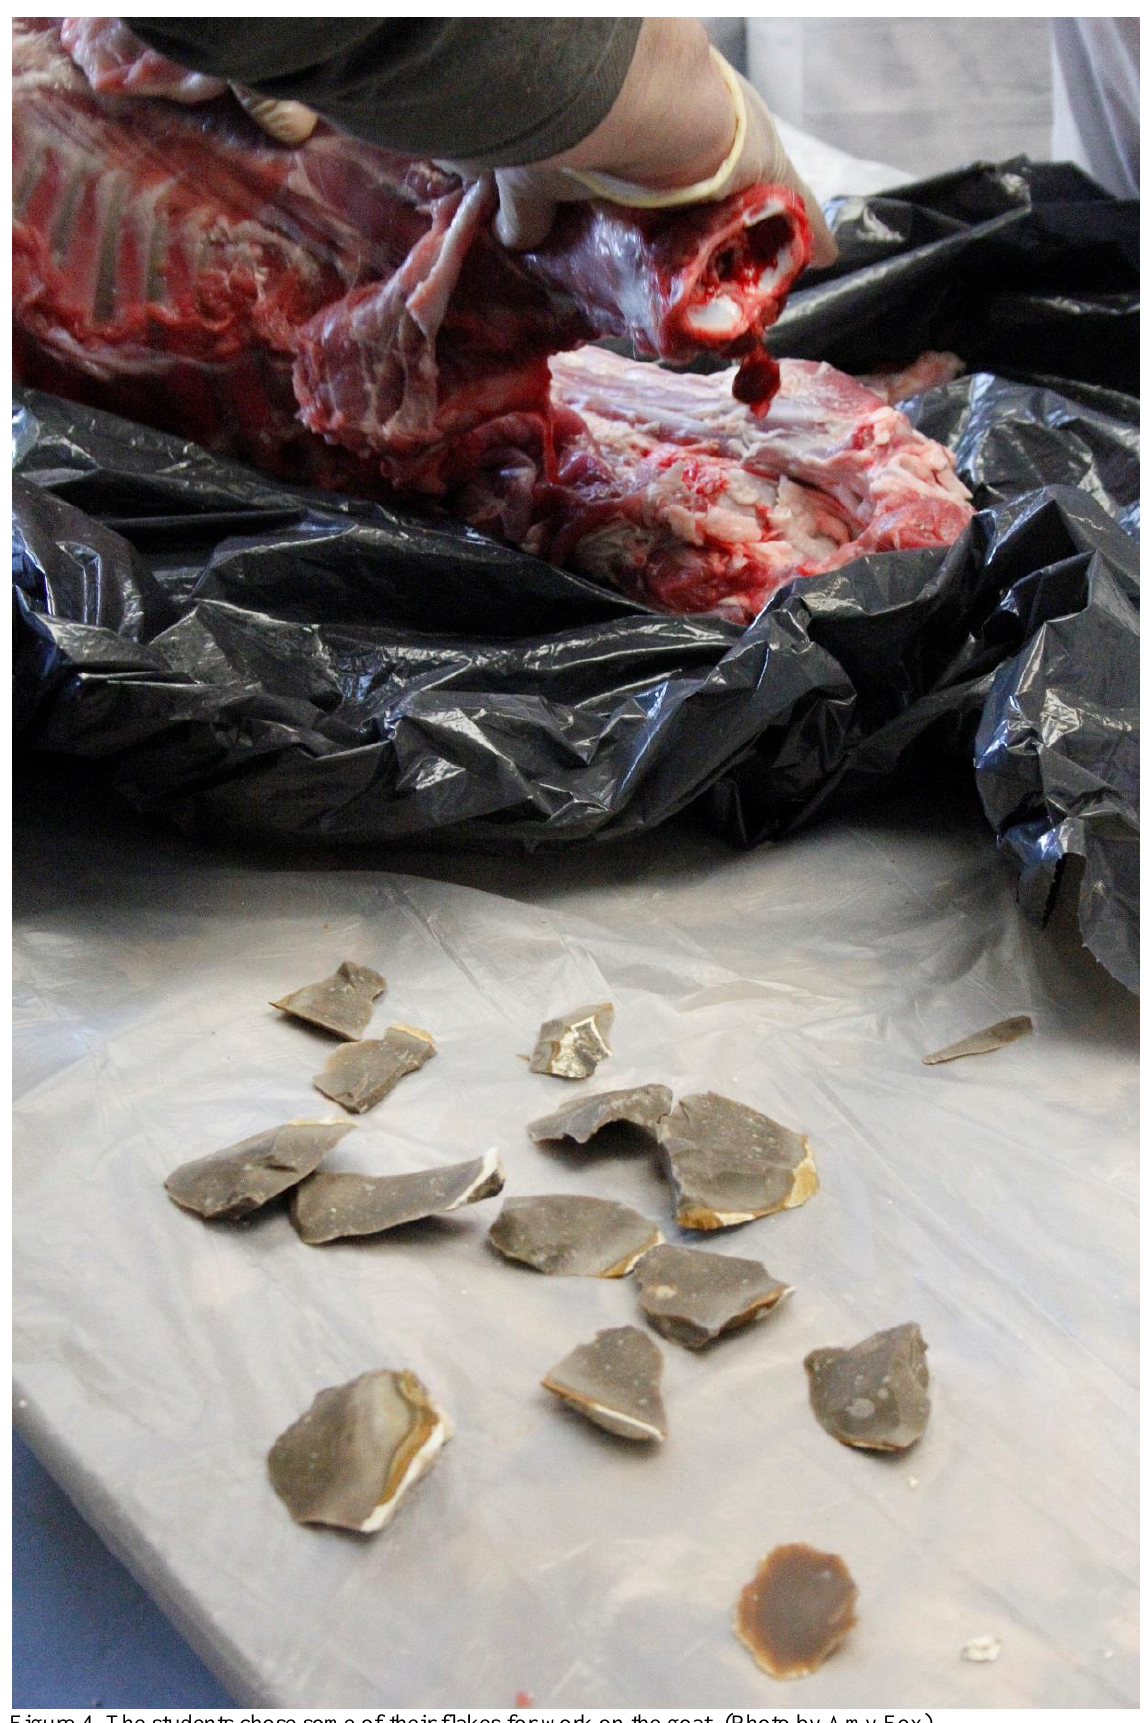
Figure 4. The students chose some of their flakes for work on the goat. (Photo by Amy